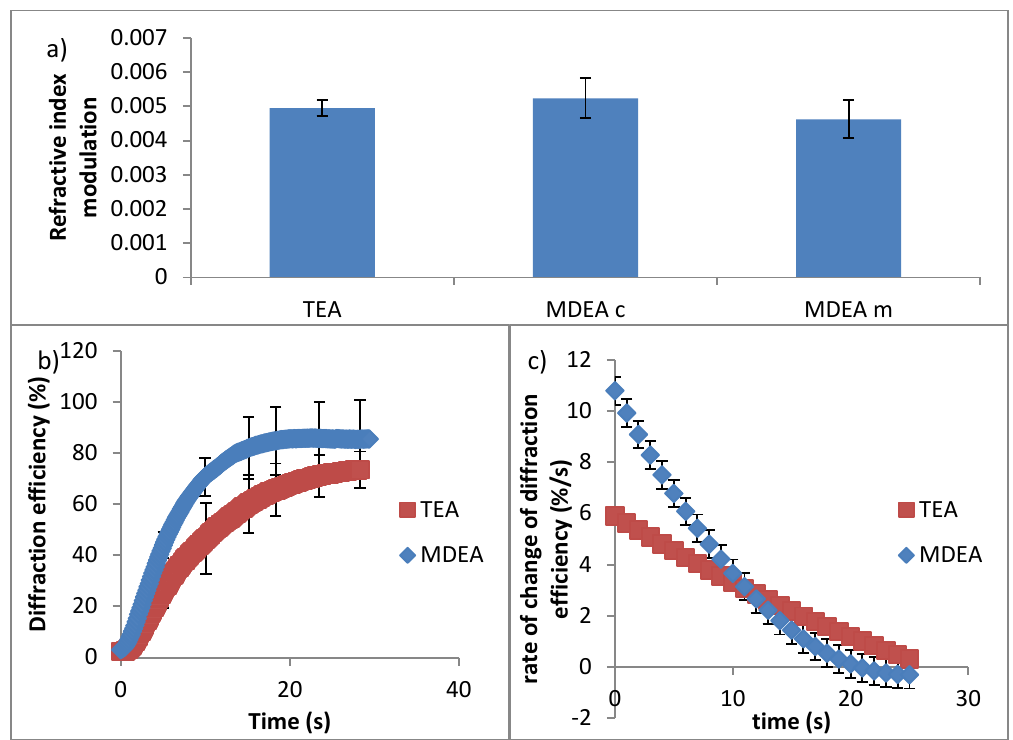
Figure 7. a) Refractive index modulation for each initiator composition. TEA, MDEA (same molar concentration), MDEA (same mass), from left to right (top) b) Growth curves (bottom left) and c) their rate of change of diffraction efficiency for TEA and MDEA with the same molar concentration (bottom right).